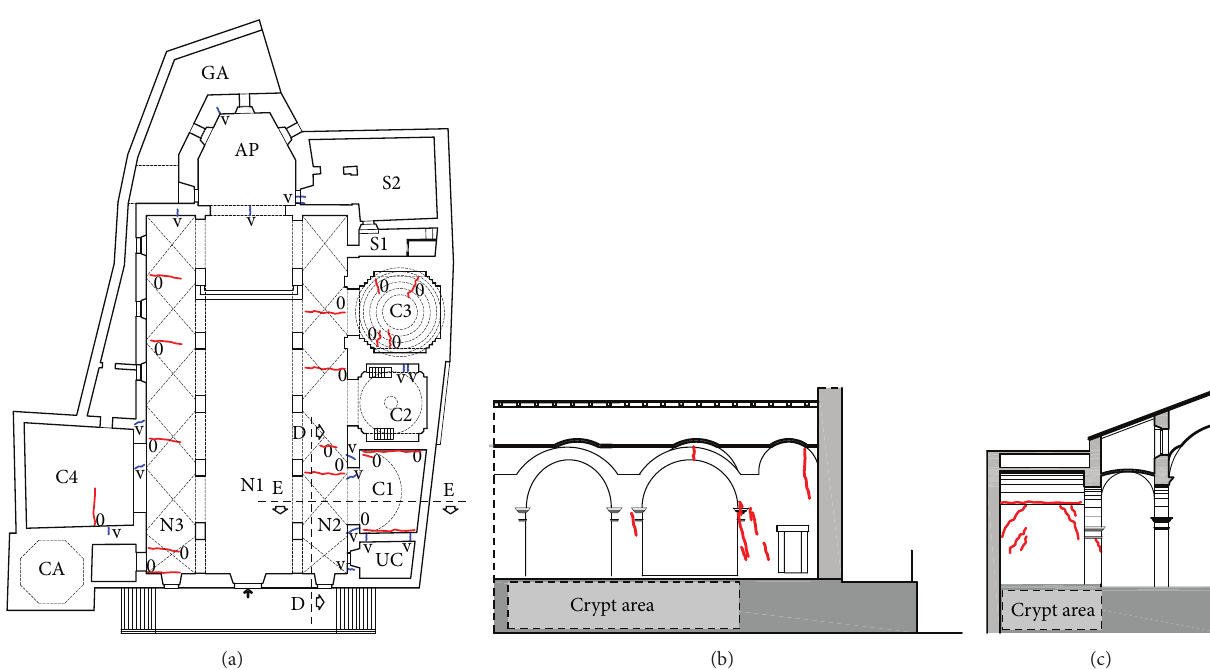
Figure 4: Madre Santa Maria del Borgo church, San Nicandro, Italy: (a) cracking pattern of the peripheral lateral walls in the area near the fac¸ade, (b) longitudinal section D-D, and (c) transversal section E-E.